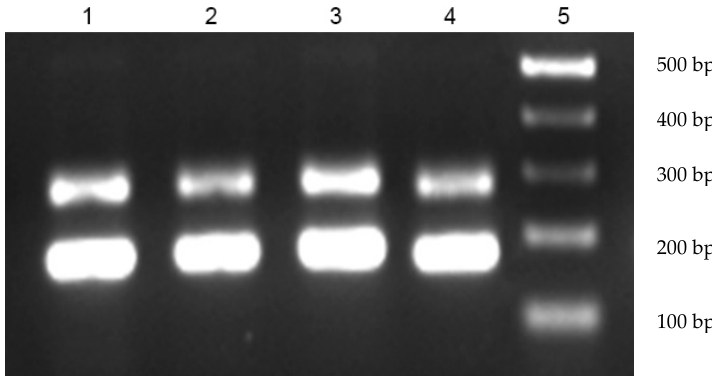
Figure 3. Agarose gel electrophoresis of Polymerase Chain Reaction (PCR) products obtained from colonies isolated from fecal samples after 42 days of intervention. 1— E. faecium from ISP; 2— E. faecium from SP; 3— E. faecium from USP; 4— E. faecium CRL 183 (pure strain); 5—1 kb DNA ladder.